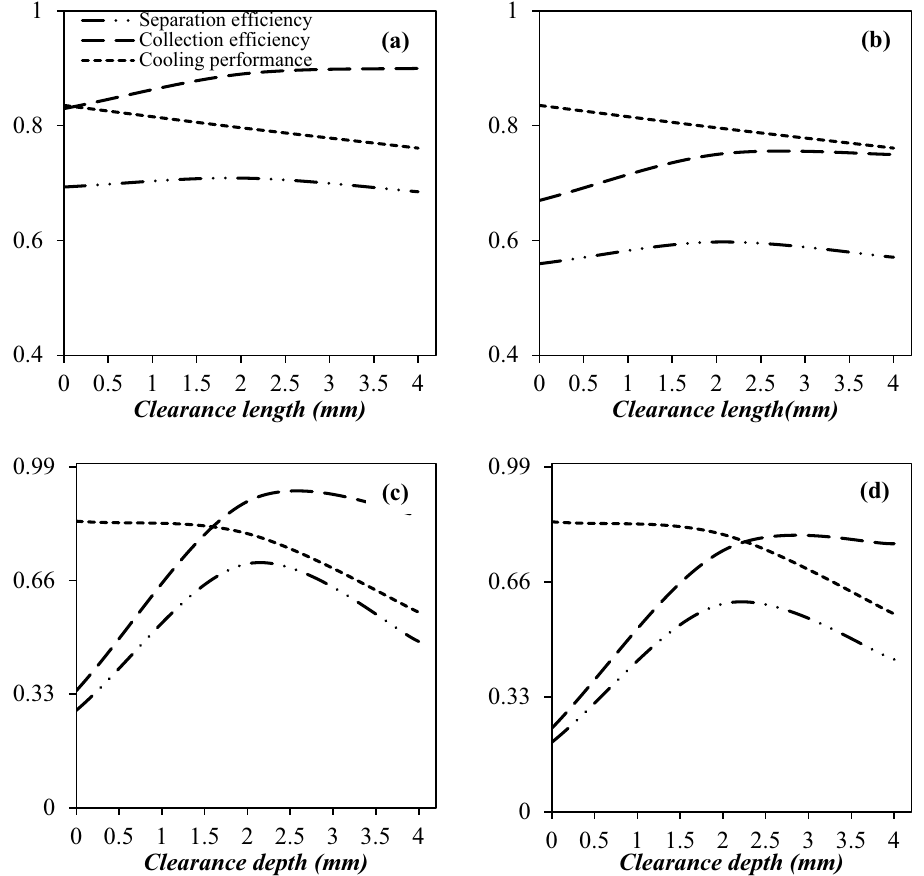
Figure 11. The influence of clearance length ( a , b ) and clearance depth ( c , d ) on the separation efficiency of water droplet ( a , c ) and condensate droplet ( b , d